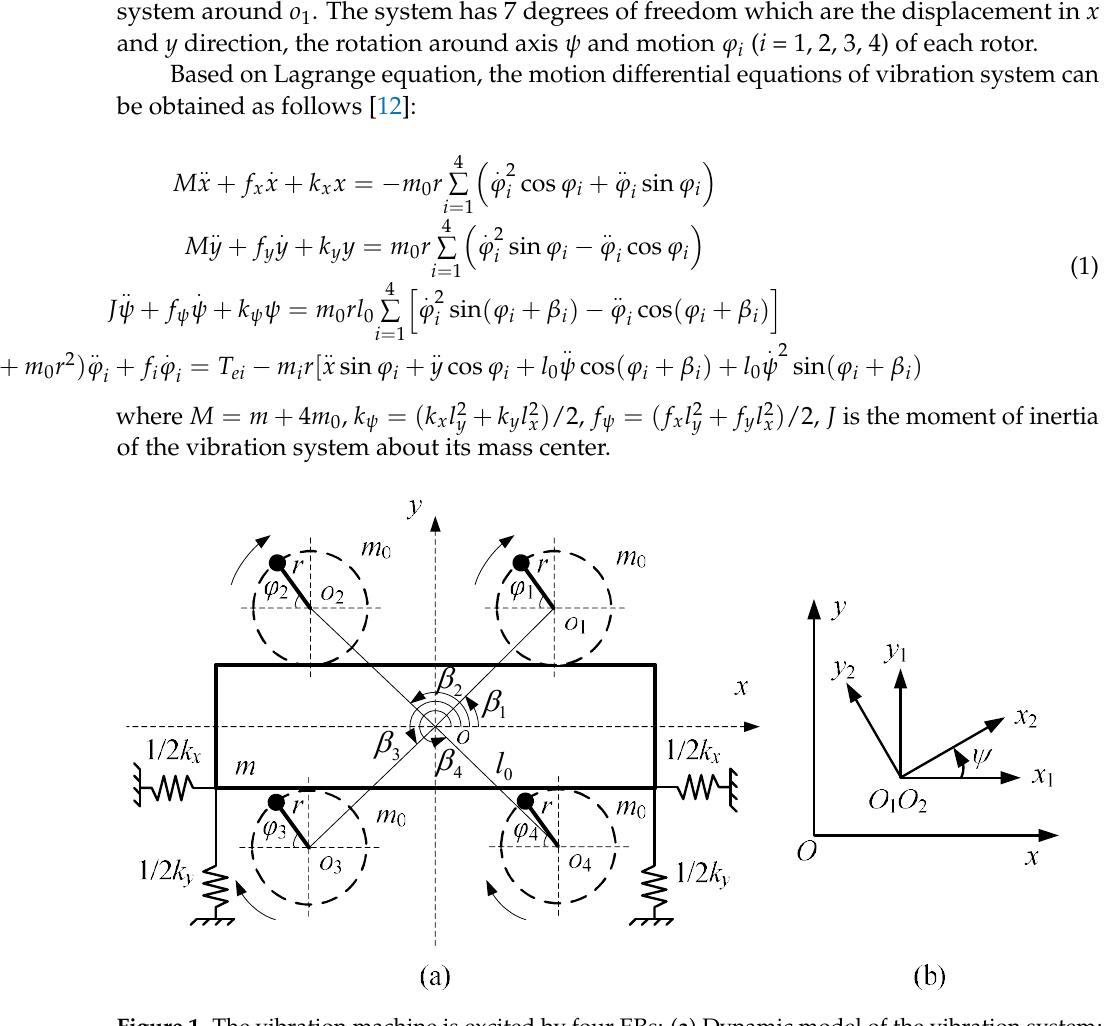
Figure 1. The vibration machine is excited by four ERs: ( a ) Dynamic model of the vibration system; ( b ) three reference coordinate systems.